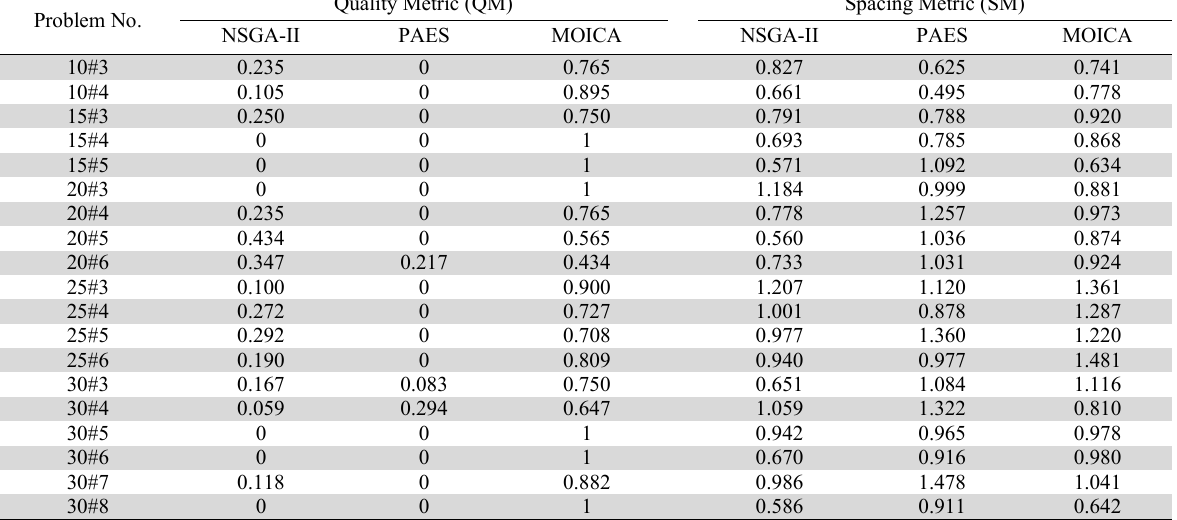
Tables (2-5) represent the performance of the proposed study for different size and number of distributions. The results of the survey for problems with sizes between 10 to 30 and distribution channels of 3 to 8 Problem No.